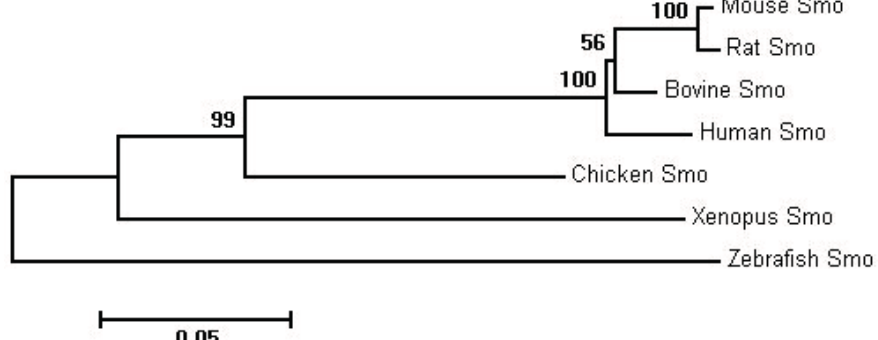
Figure 1. Phylogenetic tree for amino acid sequences of the SMO gene in seven species with bootstrap confidence values at the branch nodes. Branch lengths indicated the evolutionary